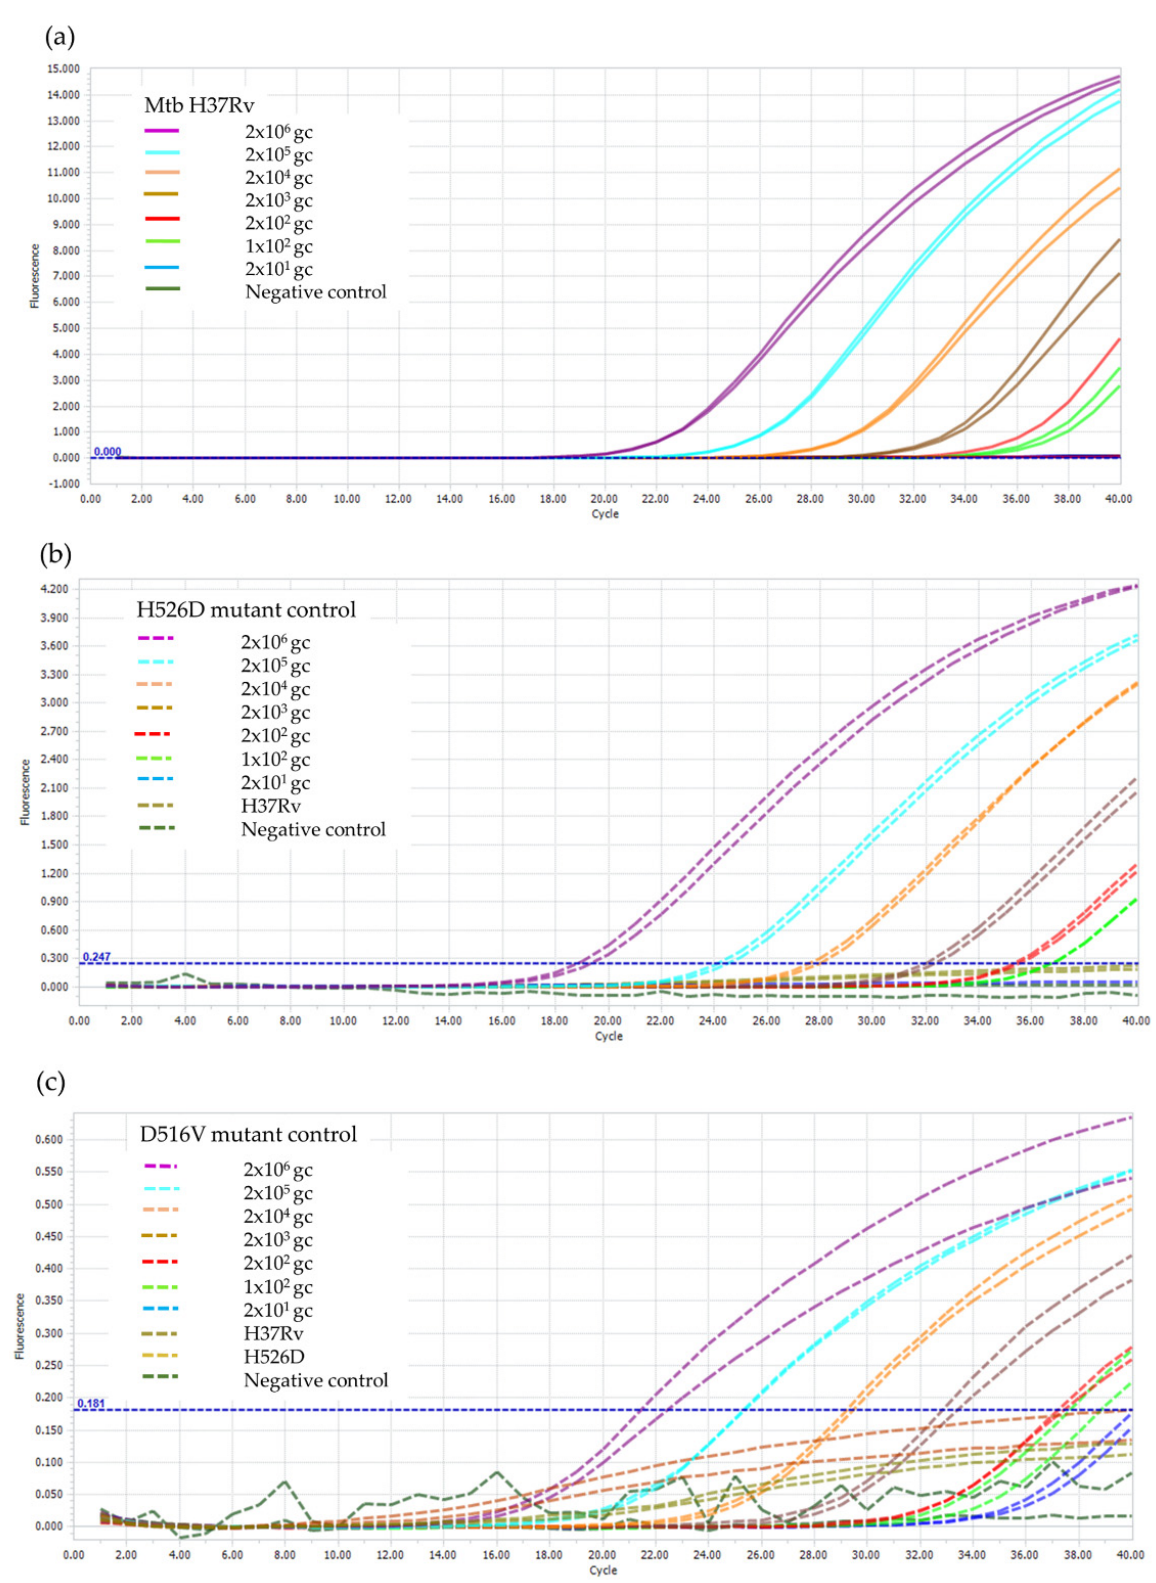
Figure 3. LOD determination of the RIF-RDp assay for detection of ( a ) rpoB gene, ( b ) H526D mutation, and ( c ) D516V mutation. The duplicate DNA samples of M. tuberculosis H37Rv (H37Rv), and the H526D and D516V mutant controls using 2 × 10 6 to 2 × 10 1 genome copies (gc) of Mtb H37Rv and negative control (sterile distilled water).